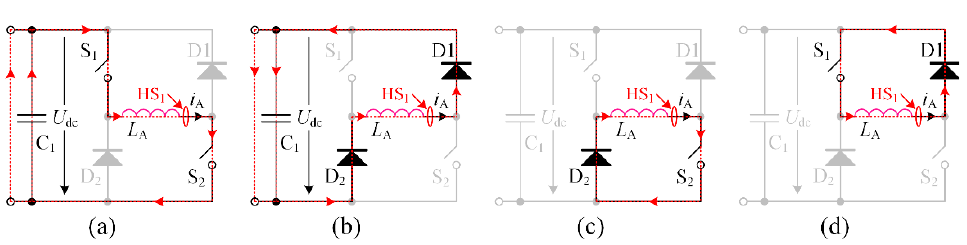
Figure 2. Operation modes of AHBC. ( a ) Excitation mode. ( b ) Demagnetization mode. ( c ) Free- wheeling mode I. ( d ) Freewheeling mode II.